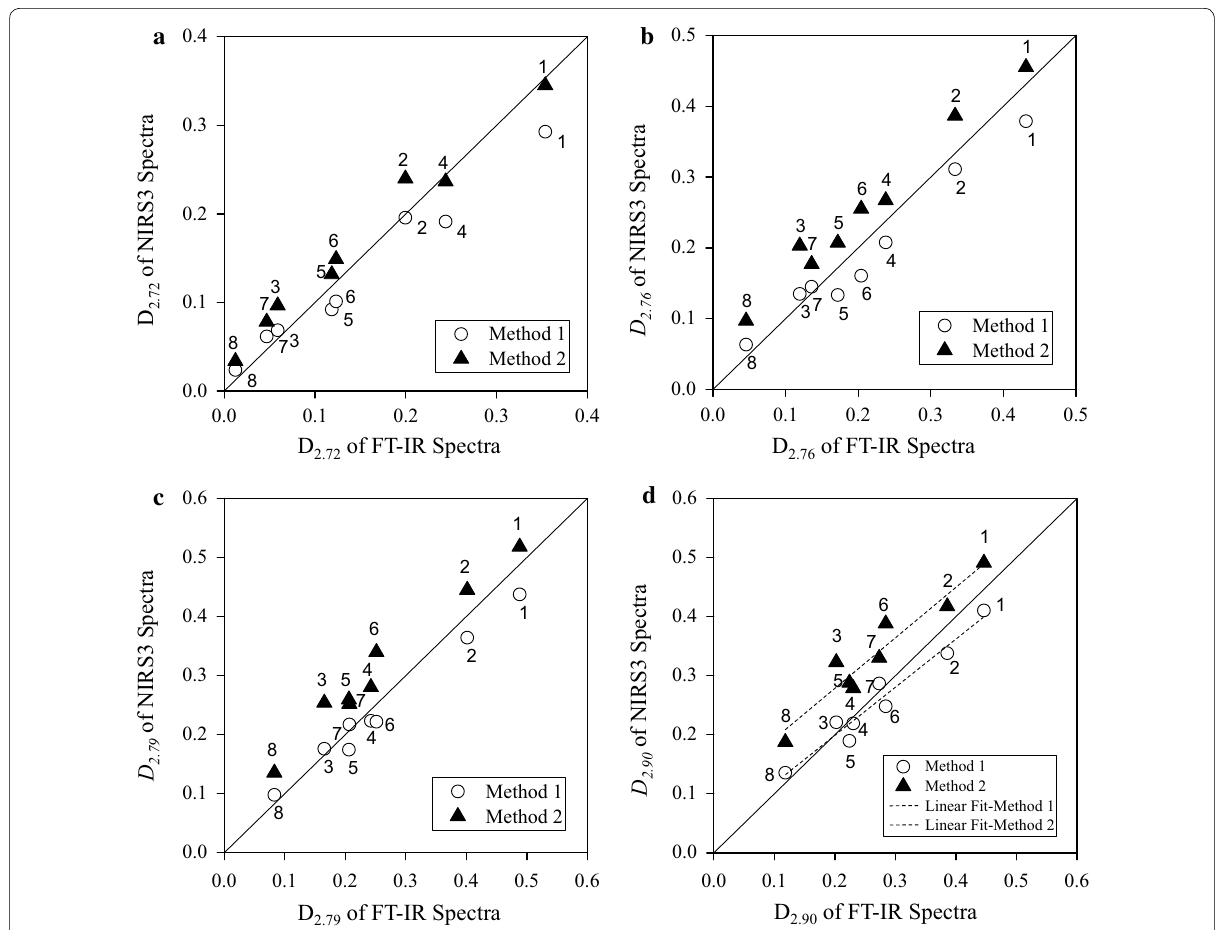
Fig. 10 Relationship of D values a at 2.72 μm, b at 2.76 μm, c at 2.79 μm, and d at 2.90 μm between FT-IR spectra and NIRS3 spectra corrected by the method 1 ( open circles ) and the method 2 ( filled triangles ). Two broken lines in d show linear fits for the data. Labels: 1 3 Y-793321, 4 Jbilet Winselwan, 5 Y 982086, 6 Y 980115, 7 Y-86720, and 8 = = = = = =